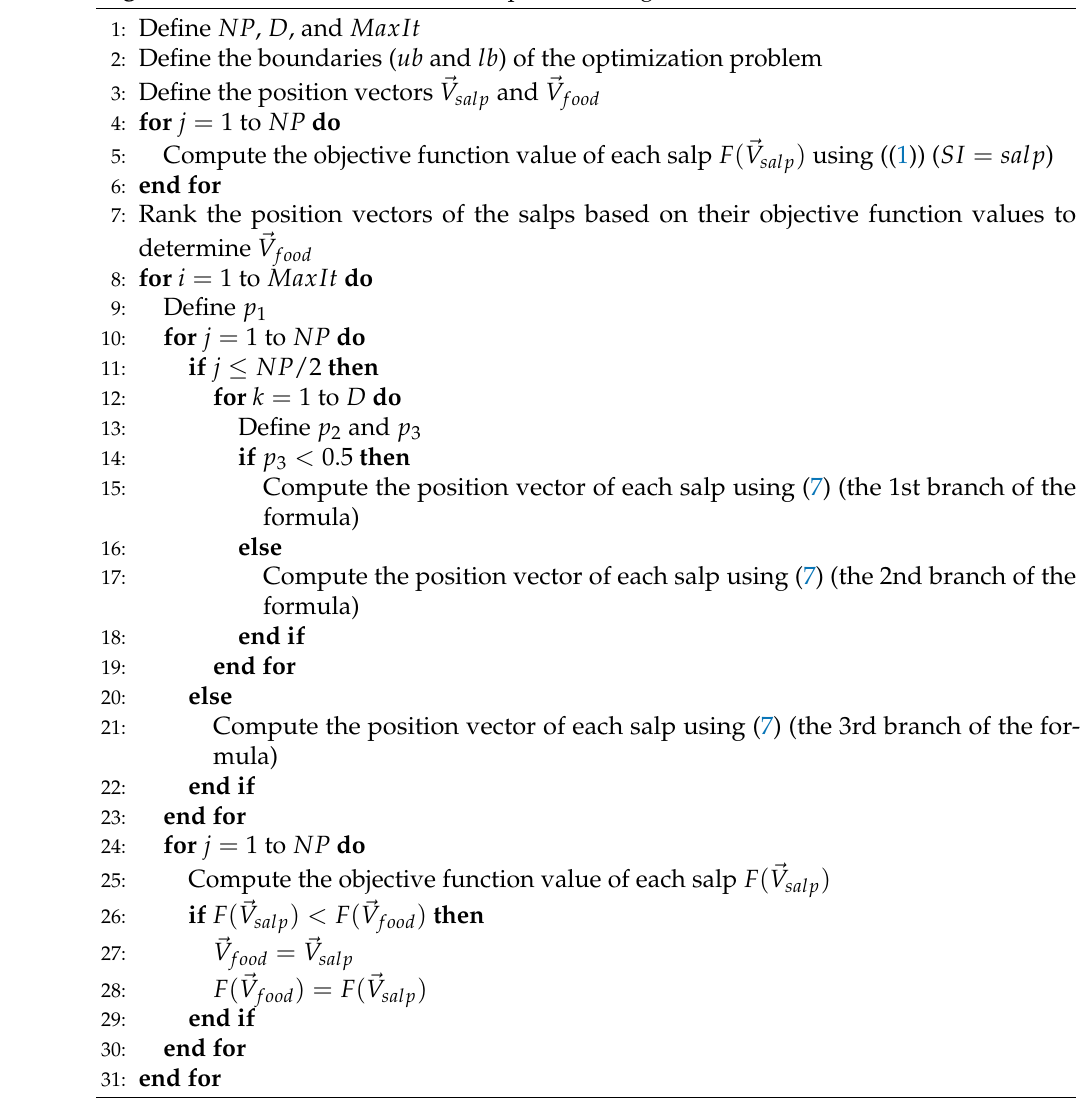
Algorithm A3 Pseudo-code of the Salp Swarm